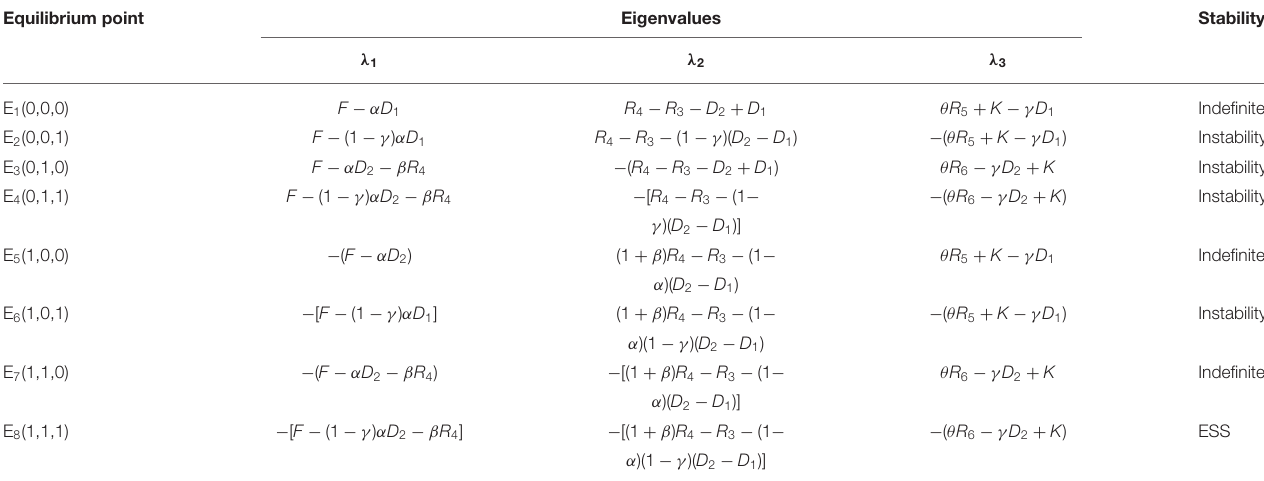
TABLE 3 | The eigenvalues and stability of the game system. Equilibrium point Eigenvalues Stability